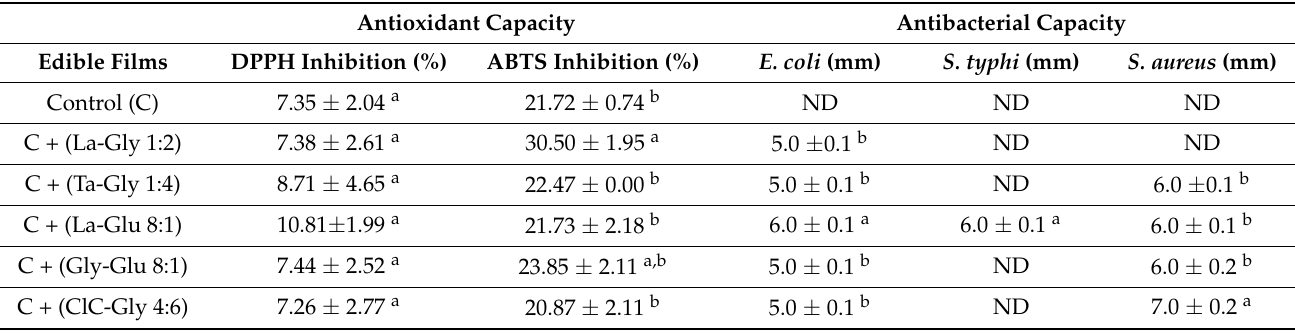
Table 3. Effect of anthocyanins obtained with different NADES on antioxidant capacity and bacterial inhibition diameter of edible